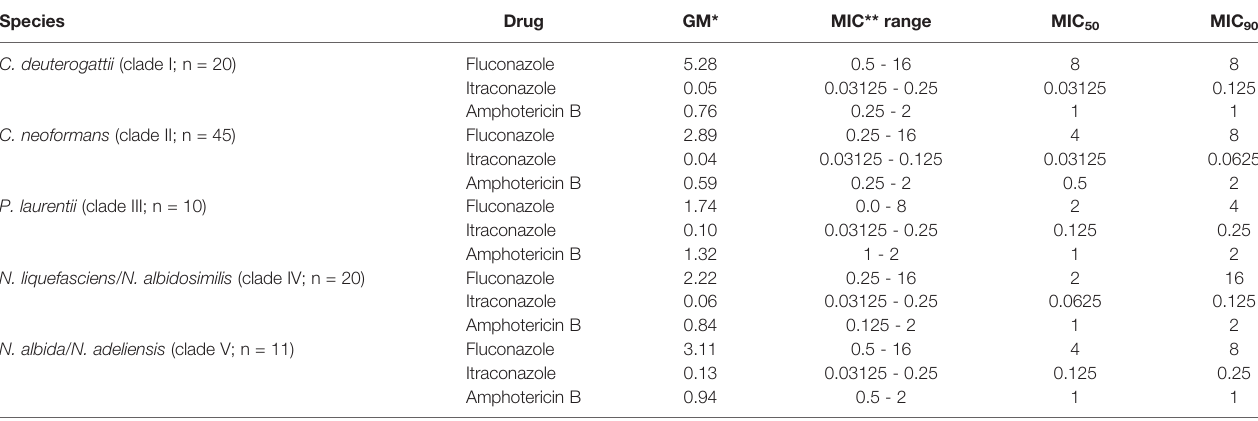
TABLE 2 | Geometric means, MIC range, MIC50 and MIC90 of clinical and environmental isolates of Cryptococcus spp. and related genera obtained from patients and pigeon droppings in Northeast Brazil. Species Drug GM* MIC** range C. deuterogattii (clade I; n =